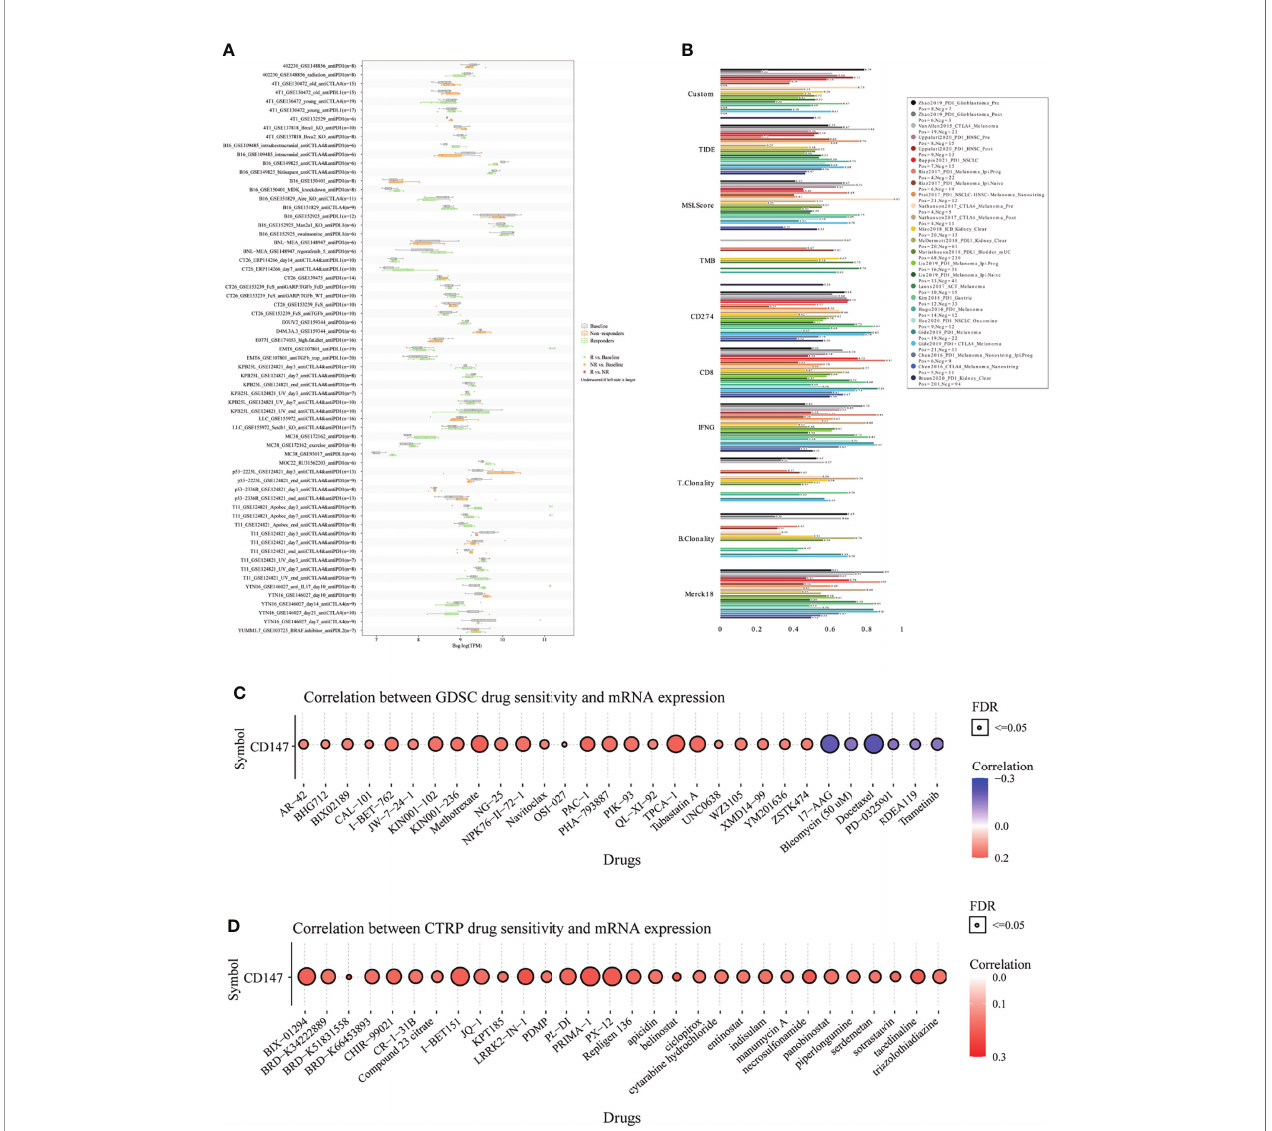
FIGURE 9 | Immunotherapy response, biomarker relevance, and sensitive drug prediction of CD147 in pan-cancer. Immunotherapy response (A) and biomarker relevance (B) of CD147 in immunotherapy cohorts. Predictive drugs based on the CD147 expression in pan-cancer from the GDSC (C) and CTRP (D)